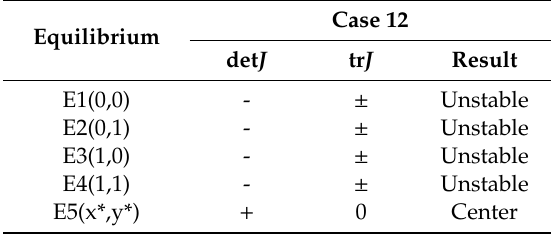
Table 10. Proposition 5: Analysis of local stability of equilibrium.